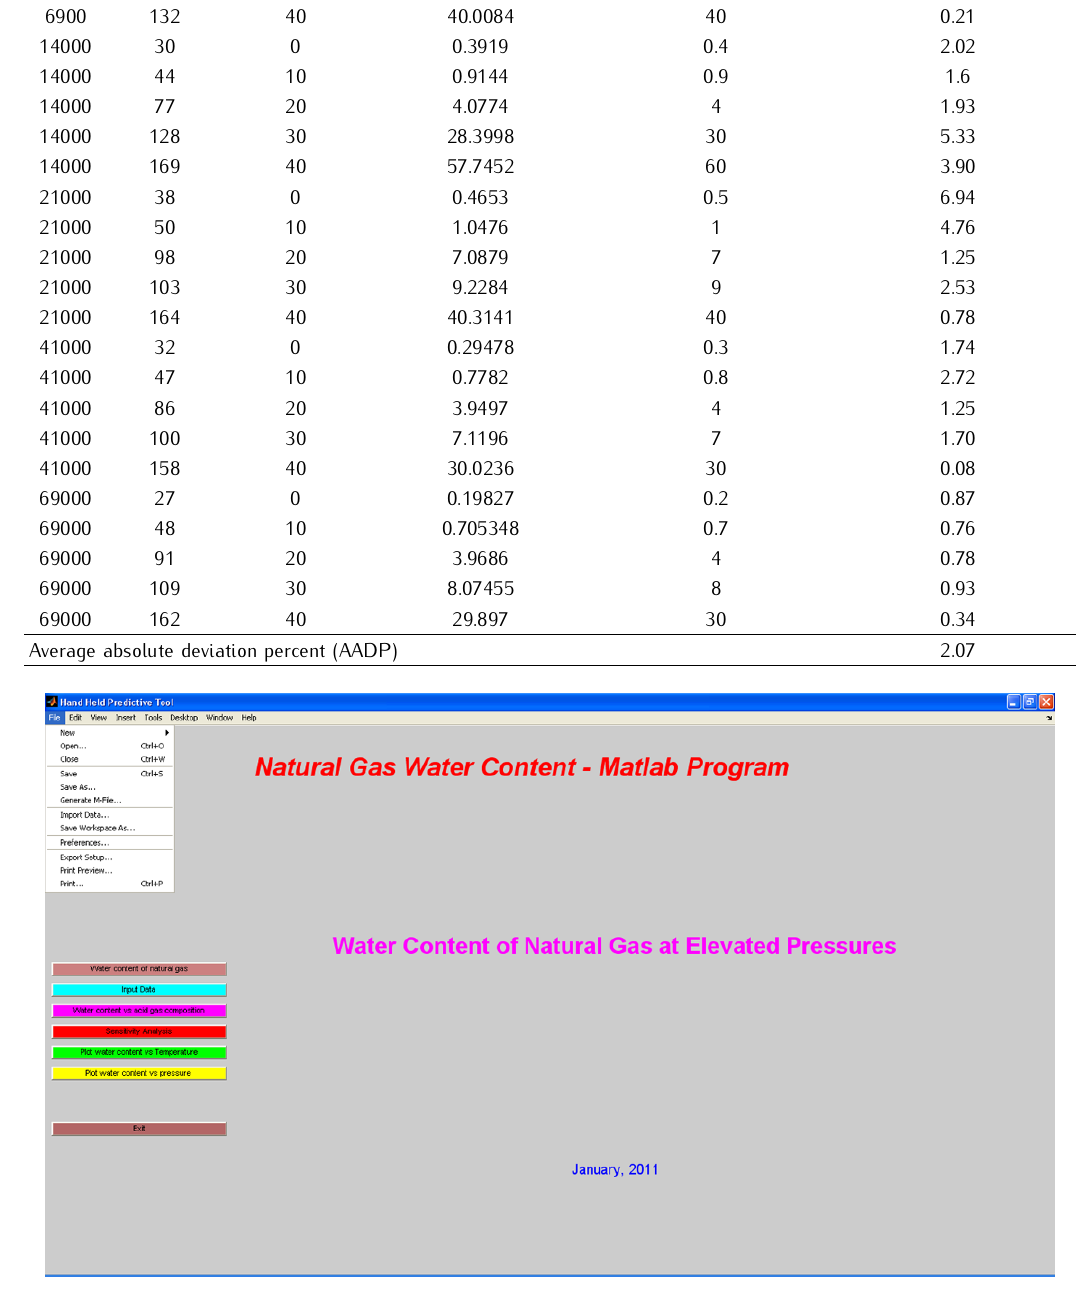
Figure 1. Developed Matlab-based [15] predictive tool for calculating sour gas water